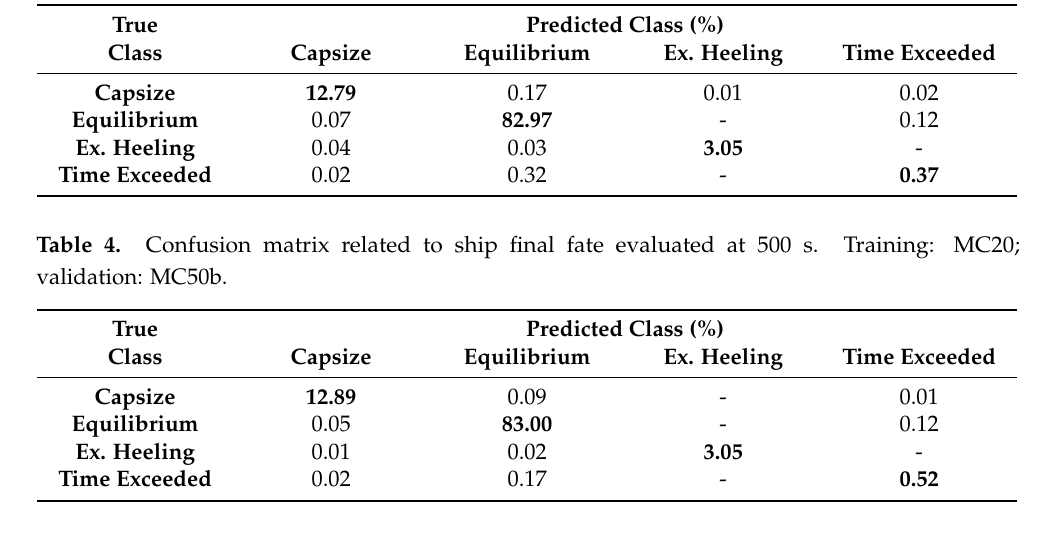
Table 3. Confusion matrix related to ship final fate evaluated at 250 s.